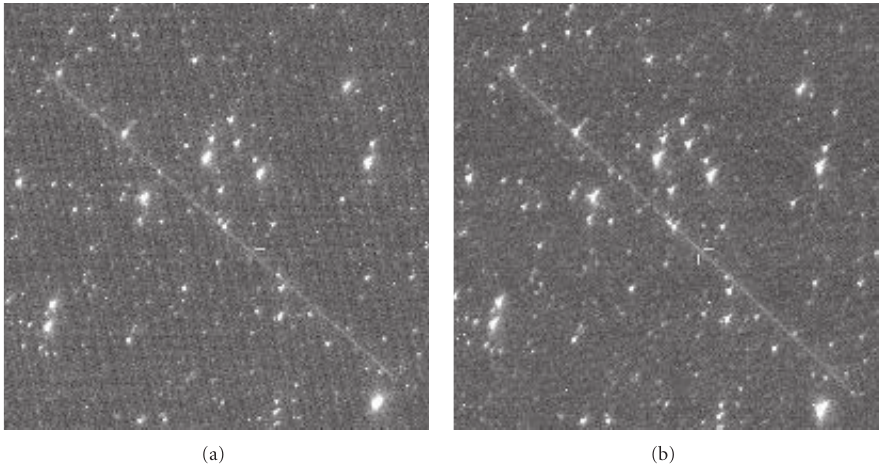
Figure 10: Parallax of an artificial satellite. Here we show the 4 ◦ × 4 ◦ frames of a sky area taken with the MASTER-VWF4 Northern and Southern cameras. Triangulation yields a height of H satell ∼ 4500 km. Given the accuracy of astrometric measurements for strip-shaped ∼ 20 (cid:3)(cid:3) , and the baselength of Δ l = 702 m, the maximum height that can be determined via triangulation is H objects, σ line astrom arcsin( σ line ) ∼ 10000 astrom